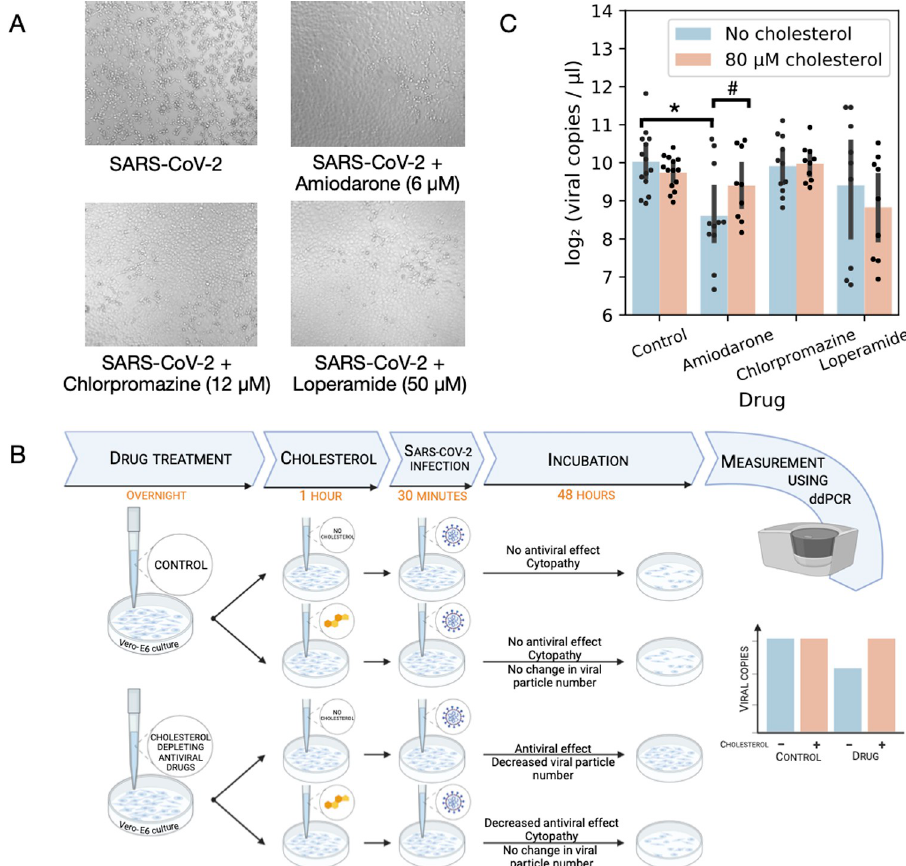
Fig 5. Cholesterol replenishment inhibits antiviral effect of amiodarone. (A) Predicted drugs inhibit SARS-CoV-2 replication in infected Vero-E6 cells. Vero-E6 cells were infected with SARS-CoV-2 (top left) and co-treated either with amiodarone (top right), chlorpromazine (bottom left) or loperamide (bottom right). Antiviral effect (reduced cytopathy) was evaluated by microscopic imaging (10x objective) 48 hours after infection. (B) Schematic figure of cholesterol rescue experiments. The figure was created with BioRender.com. (C) Effect of cholesterol rescue on antiviral drug effect. Vero-E6 cells were pretreated with drugs (x-axis), cholesterol was replenished (color code) and cells were infected with SARS-CoV-2. Antiviral effect of drugs was evaluated 48 hours after infection by droplet digital PCR (viral copies, y-axis). � , #: significant (p < 0.05) effect of drug treatment and drug treatment-cholesterol interaction in linear model,